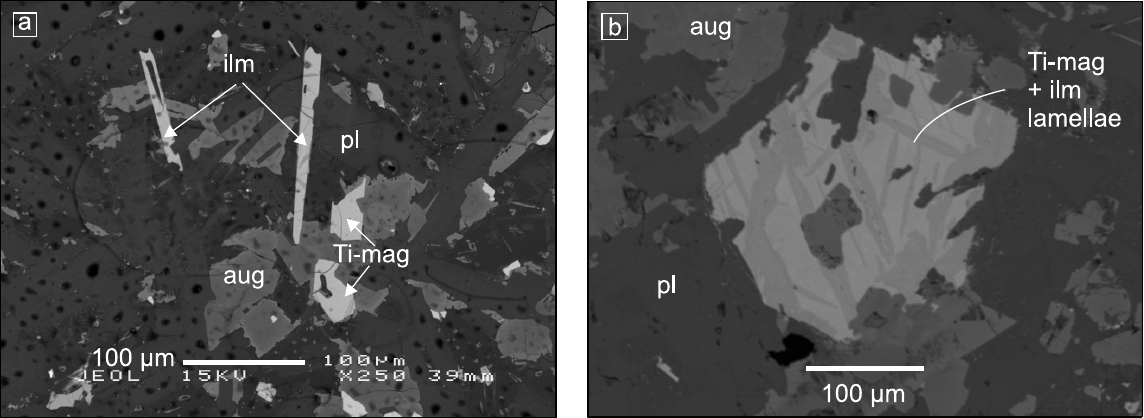
Fig. 4 – BSE images; (a) ilmenite and Ti-magnetite pair in flow 4; (b) ilmenite lamellae in Ti-magnetite grain from flow 11. Ti/Zr ratios are similar in all flows, but slightly higher in flows 1-5 ( ∼ 85) than in flows 6-13 ( ∼ 80). Based on these ratios and the TiO 2 contents (Fig. 6), the flows are Pitanga-type at the base of the stratigraphic section (flows 1-5) and Paranapanema type in the upper portion